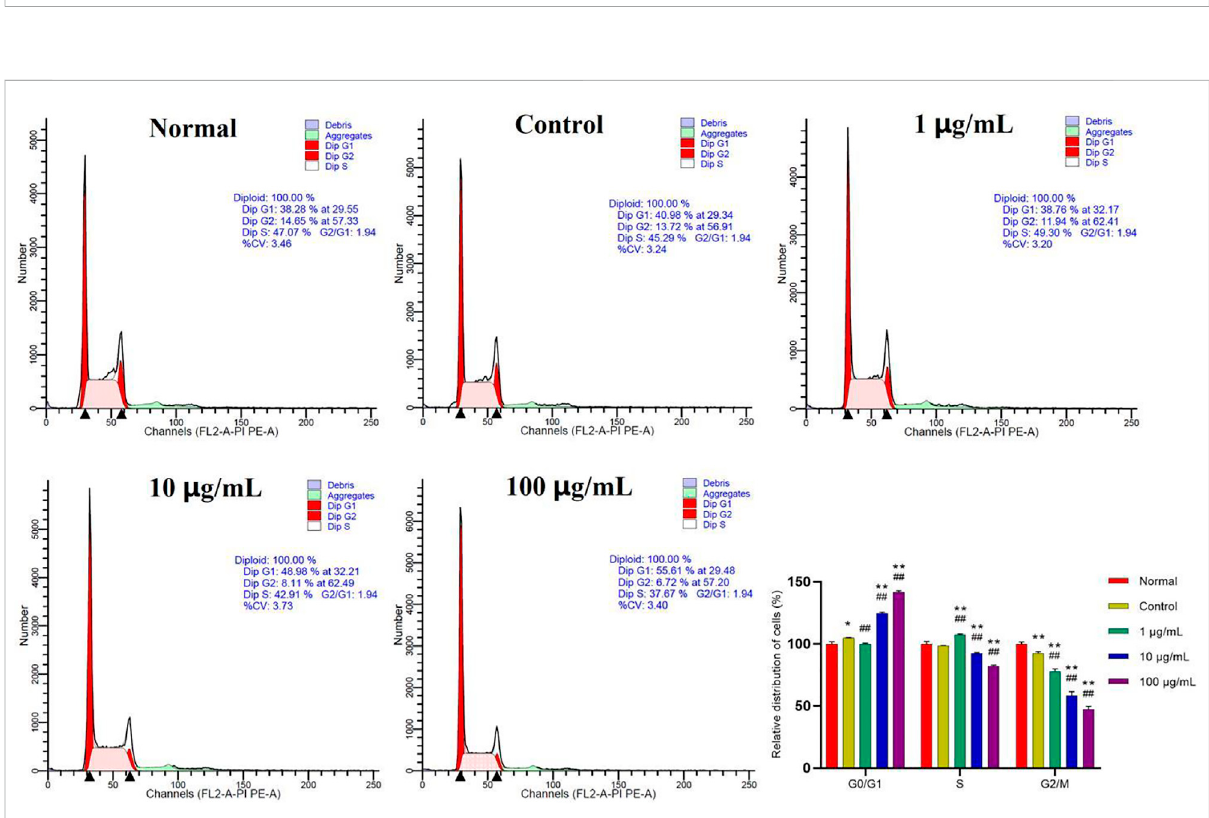
The effects of FTAs on cell cycle of TNF- α -induced MH7A cells. MH7A cells were intervened by corresponding concentrations of FTAs in absence or presence of 20 ng/ml TNF- α for 24 h, and then the cell cycle of MH7A cells was measured by fl ow cytometer. The experimental results were recorded as mean ± SD ( n = 3). * p < 0.05, ** p < 0.01 vs. normal, # p < 0.05, ## p < 0.01 vs.